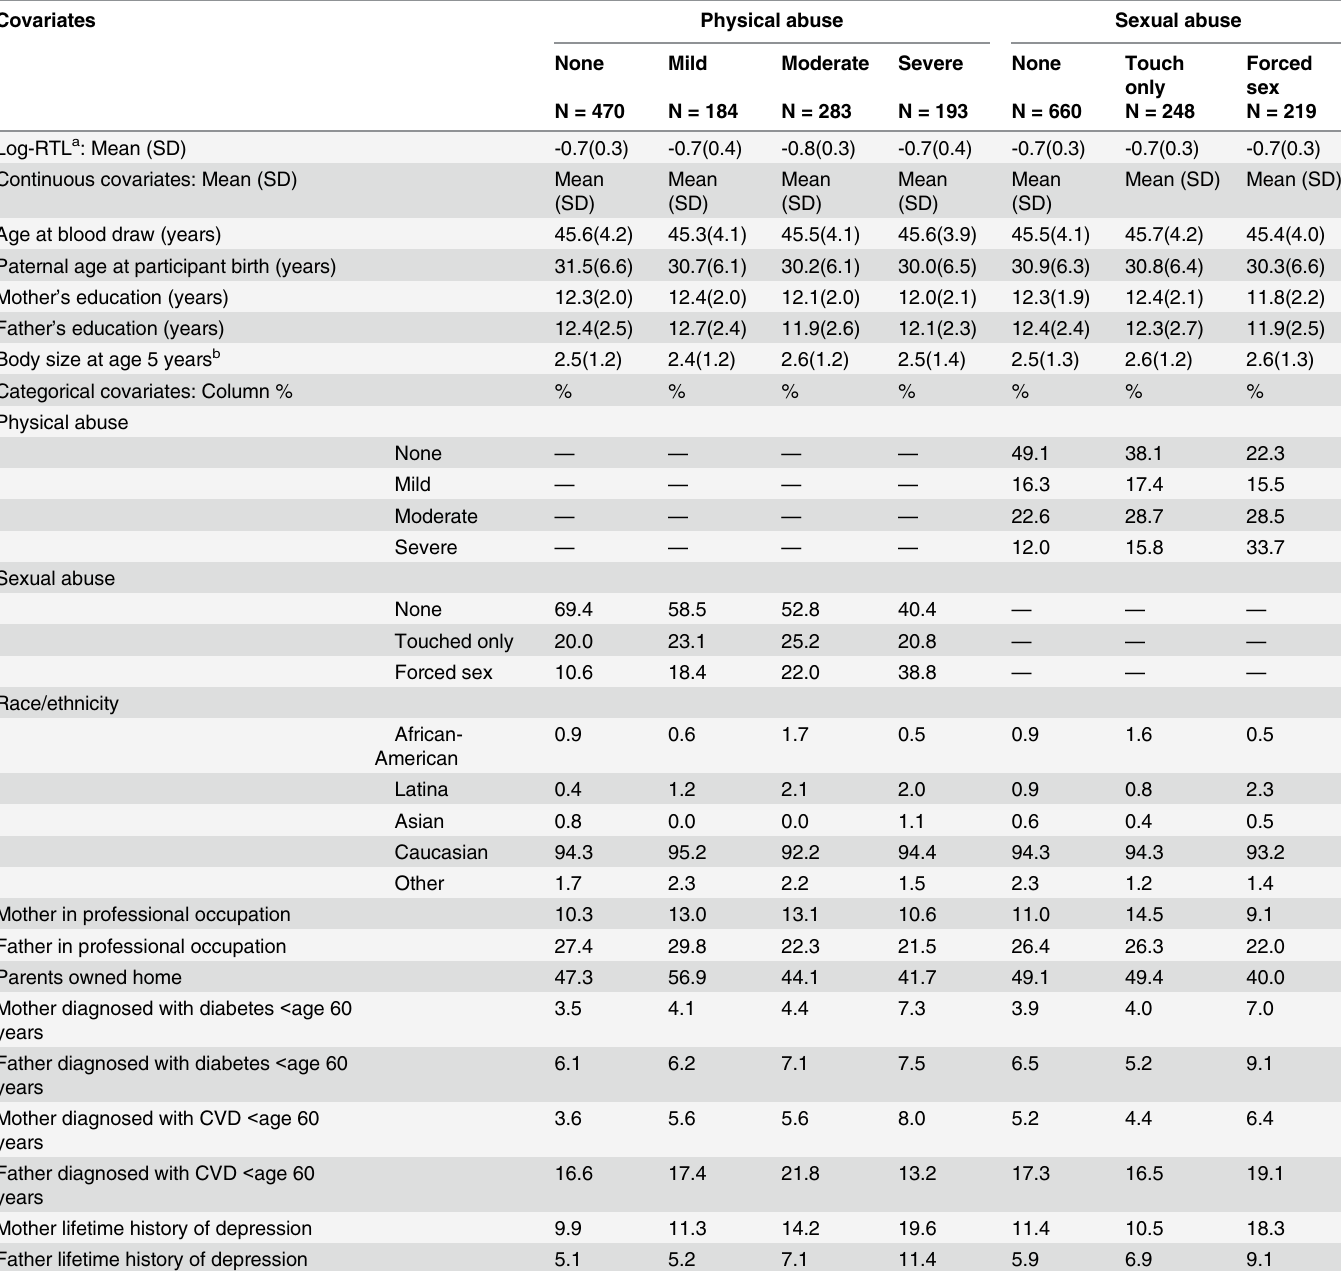
Table 1. Distribution of relative telomere length (RTL) and covariates across categories of childhood physical and sexual abuse severity: Nurses ’ Health Study II .